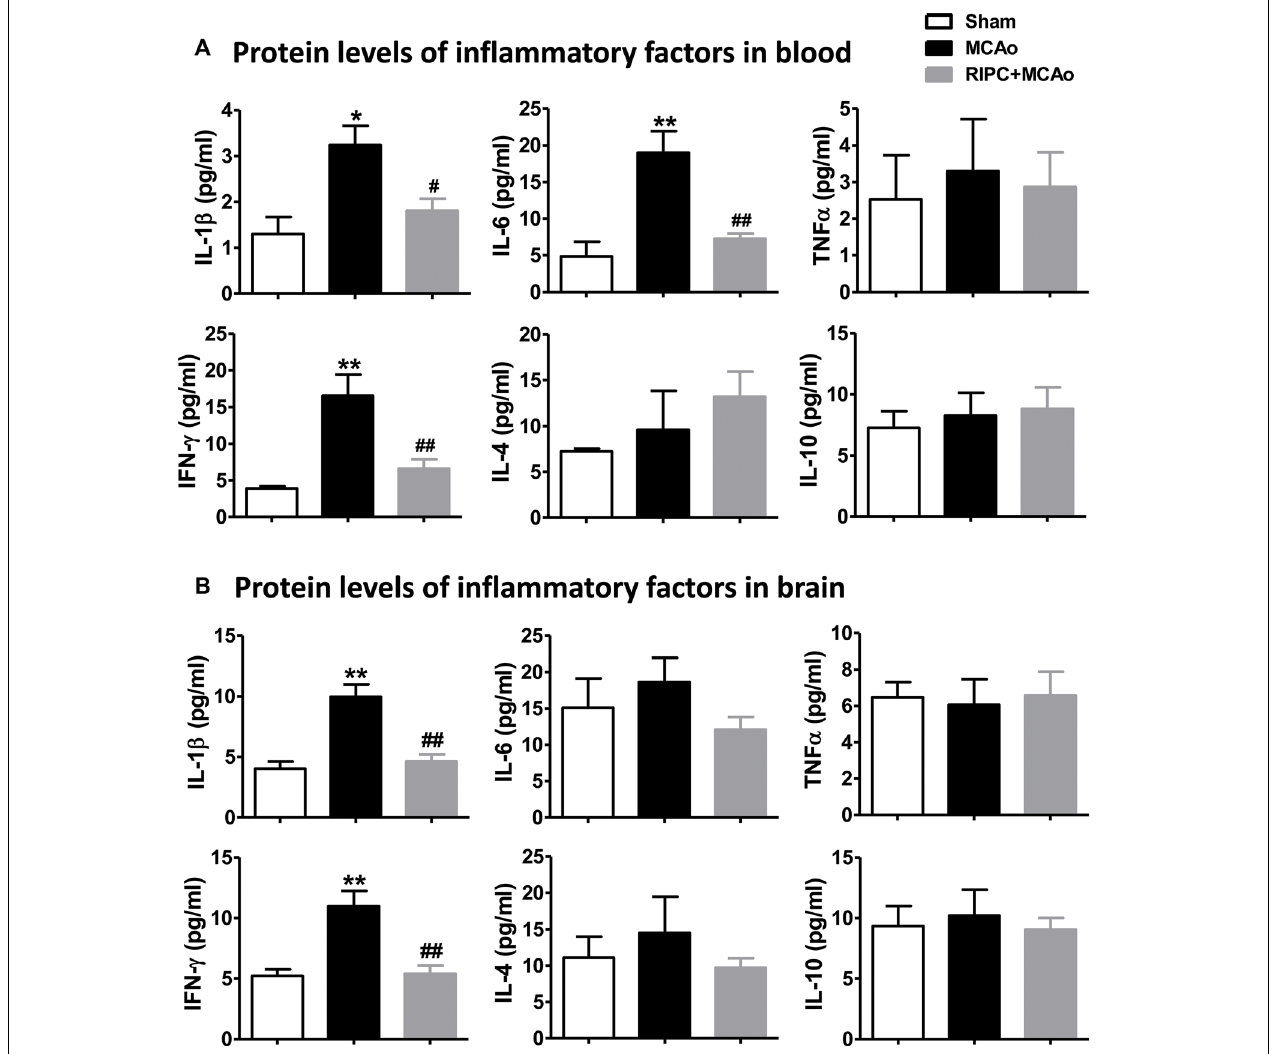
FIGURE 3 | The effects of RIPC on inflammatory cytokines in the peripheral blood and brain. (A) Protein levels of the pro-inflammatory cytokines IL-1 β , IL-6, TNF α and IFN- γ and anti-inflammatory cytokines IL-4 and IL-10, respectively, in the peripheral blood. A total of three groups were evaluated: Sham, MCAo, RIPC+MCAo. (B) Protein levels of IL-1 β , IL-6, TNF α IFN- γ IL-4 and IL-10, in the ischemic brain. All samples were collected 48 h after stroke ( N = 5–6 per group). * , ** vs. Sham, p < 0.05, 0.01, #,## vs. MCAo, p < 0.05, 0.01, respectively.